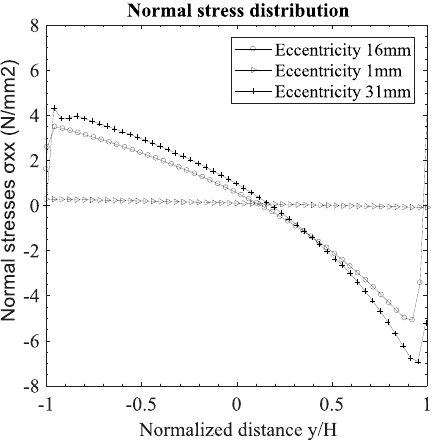
Fig. 17 Normal stress distribution at varying